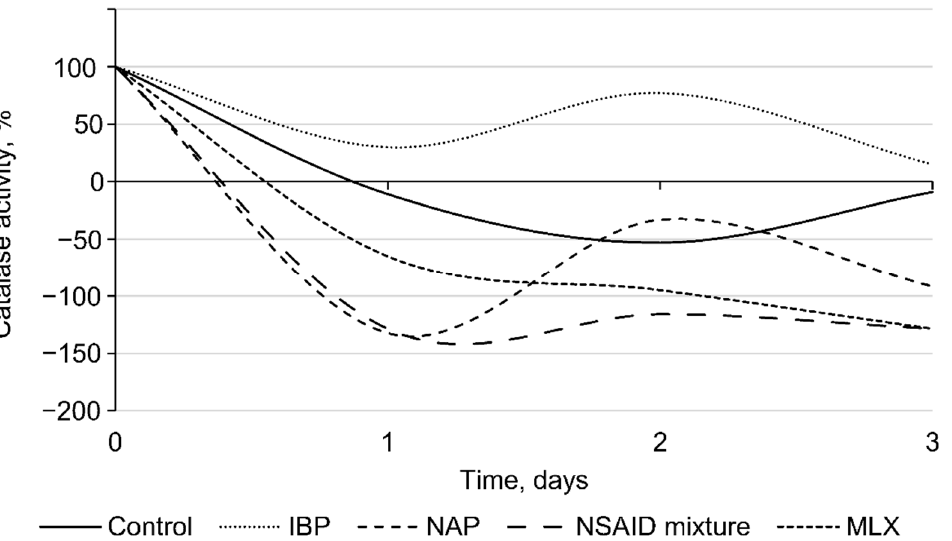
Figure 6. Catalase activity of R . cerastii IEGM 1278. Cells were grown in the presence of 0.1 g/L glucose (control), 0.1 g/L glucose and selected NSAIDs (ibuprofen, IBP; naproxen, NAP; and meloxicam, MLX), and their mixture. The data are presented as mean values ± standard deviations ( n = 3).